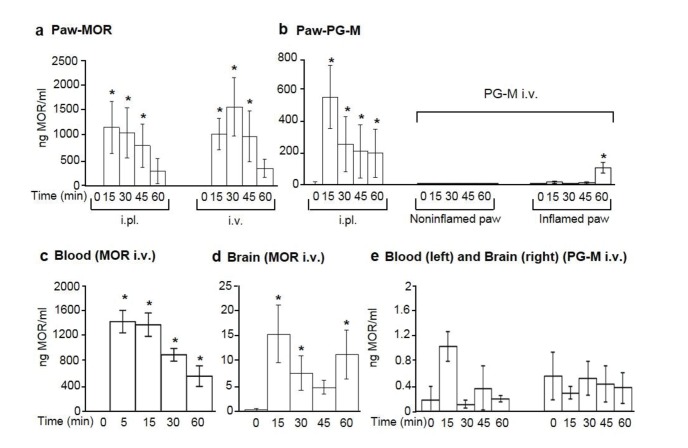
Concentrations of free morphine in paw microdialysates, blood, and brain.Concentrations in paw microdialysates after intraplantar (i.pl.; 100 μg morphine free base equivalent; N = 7) or intravenous (i.v.; 6 mg/kg morphine free base equivalent; N = 7) administration (at time 0) of morphine (MOR) (a) or PG-M (b). Blood and brain concentrations after i.v. injection of morphine (c, N = 8; d, N = 7) or PG-M (e; N = 6 for blood; N = 7 for brain) (6 mg/kg morphine-free base equivalent in both cases). Each sample was divided for duplicate measurements by ELISA. (a, b, c) *p<0.05, one-way RM-ANOVA and Bonferroni tests (compared to corresponding values before injections, that is, at 0 min). (d) *p<0.05, Kruskal-Wallis one-way ANOVA on ranks and Dunn test (compared to values before injection); means ± SEM.DOI:
http://dx.doi.org/10.7554/eLife.27081.01610.7554/eLife.27081.017Figure 9—source data 1.Raw data for Figure 9.